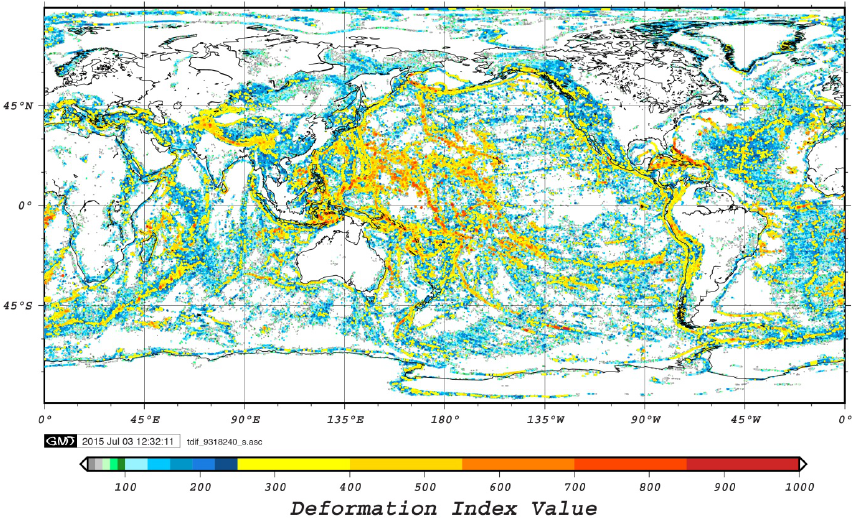
Figure 12. World view of deformation index value (1–1000) based on a global topographic grid at 5arcmin spacing. At each grid location, the maximum relief in meters of the location with the eight adjacent surrounding locations is divided by 5 to obtain its deformation index